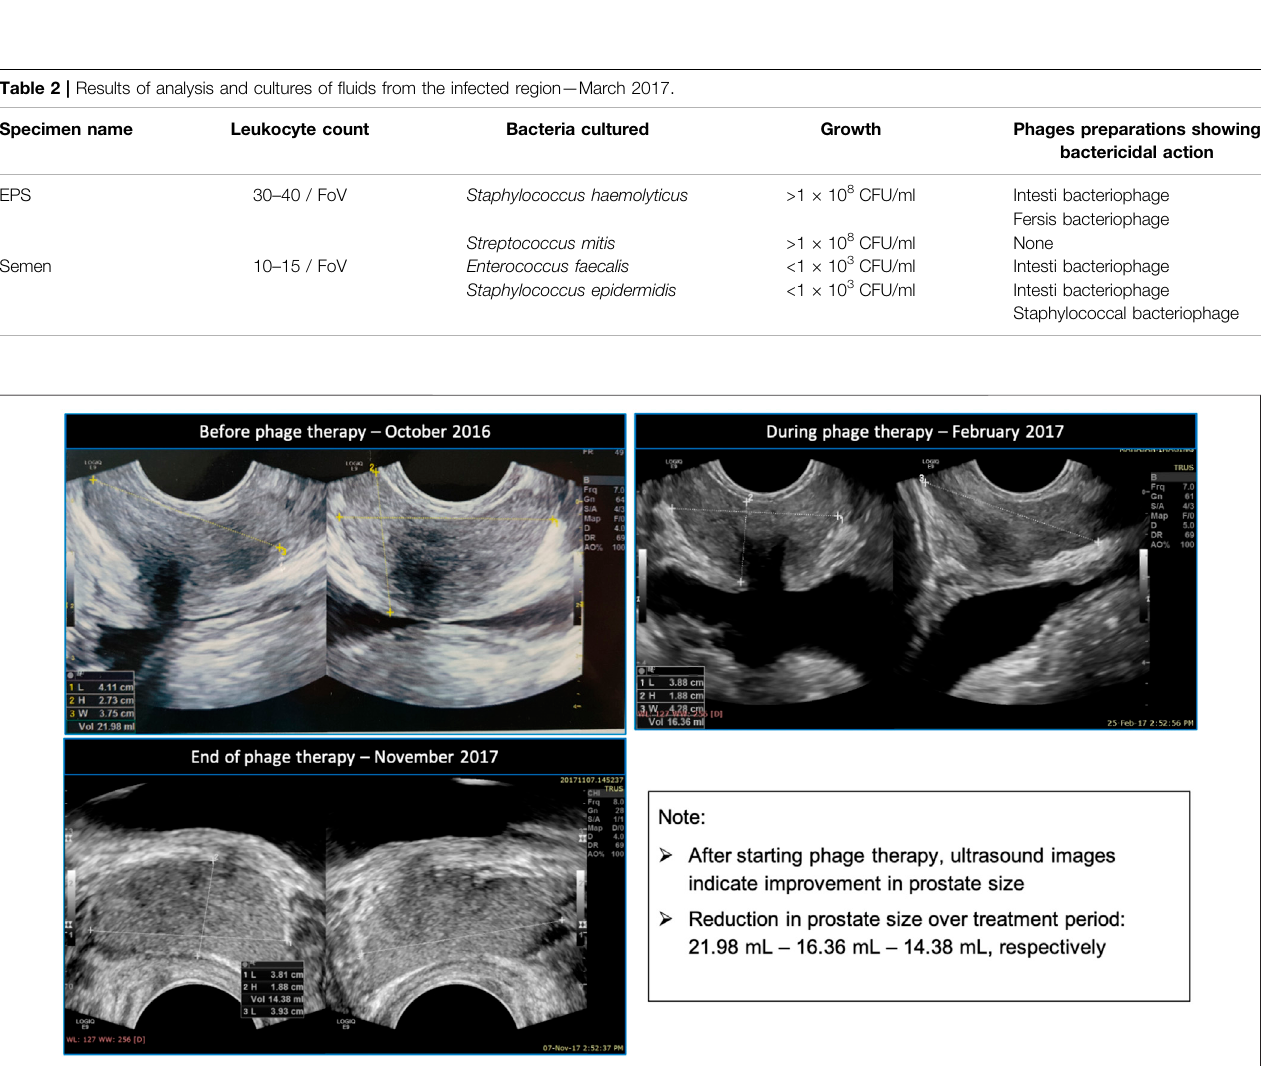
Frontiers in Pharmacology |